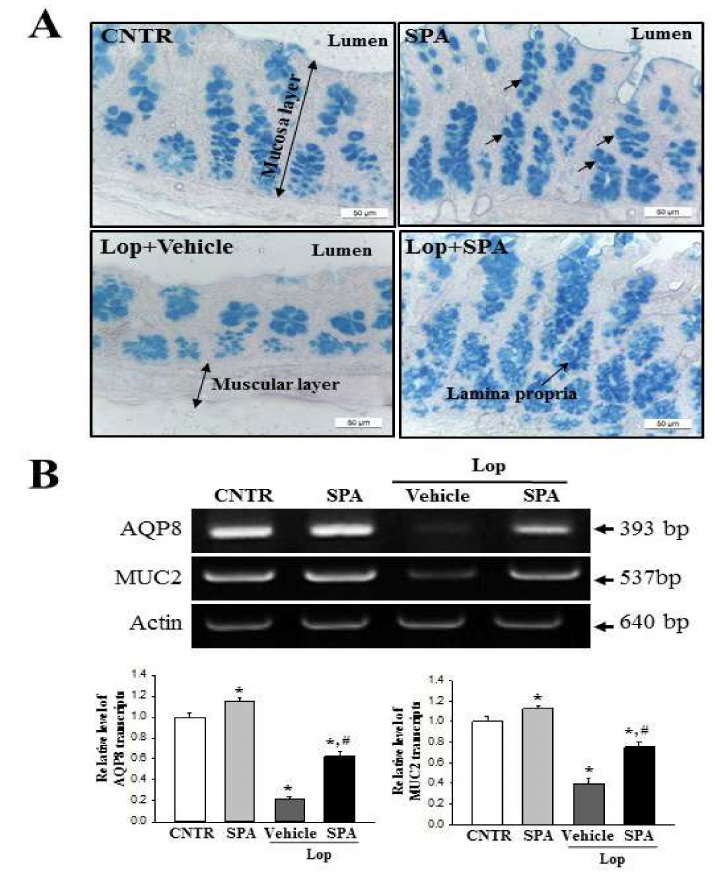
Figure 7. The detection of mucin secretion and membrane water channel expression in the colon after SPA treatment: ( A ) Mucin secreted from the crypt layer cells was stained with Alcian Blue at pH 2.5, and the images were observed at 100 × magnification. Five to six rats per group were used in the preparation of the tissue slide and mucin secretion observed in duplicate in three stained slides. ( B ) The levels of MUC2 and AQP8 transcripts in the total mRNA of the colons were measured by RT-PCR using specific primers. After the intensity of each band was determined using an imaging densitometer, the relative levels of MUC2 and AQP8 mRNA were calculated based on the intensity of actin as an endogenous control. Four to five rats per group were used in RNA purification, and each transcript levels were assayed in duplicate in each sample. The data are reported as the mean ± SD. * indicates p < 0.05 compared to the CNTR group. # indicates p < 0.05 compared to the Lop + Vehicle-treated